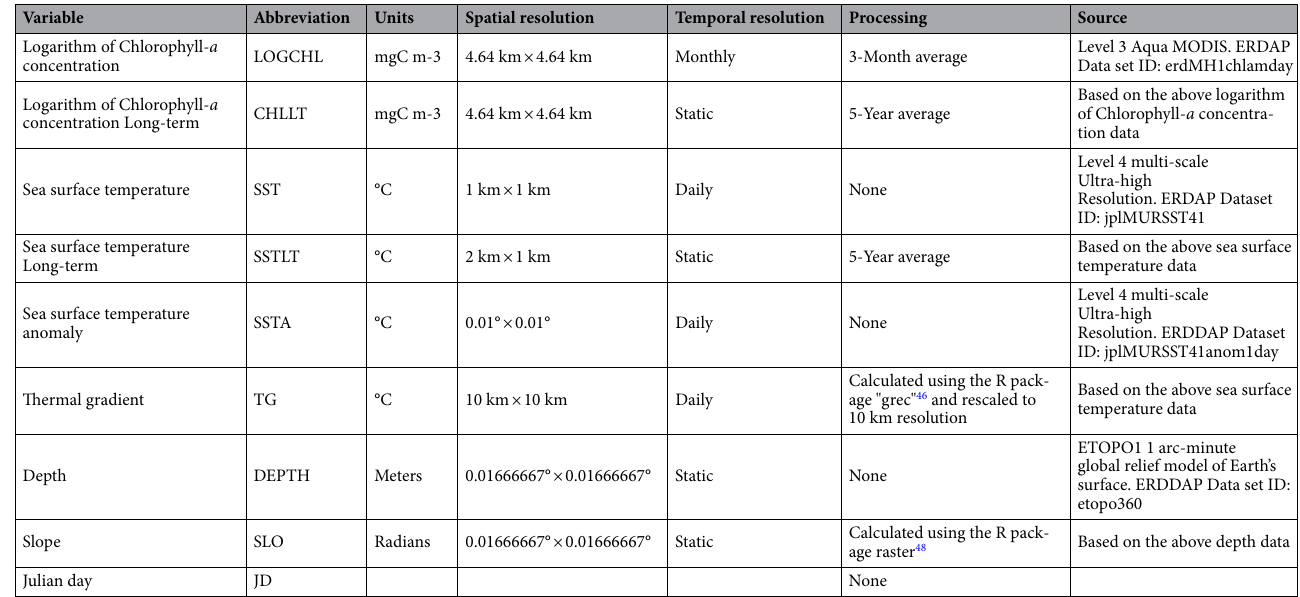
Table 1. Summary information for all predictors used for modeling cetacean abundance and distribution. The processing column indicates how were the data manipulated after extraction from